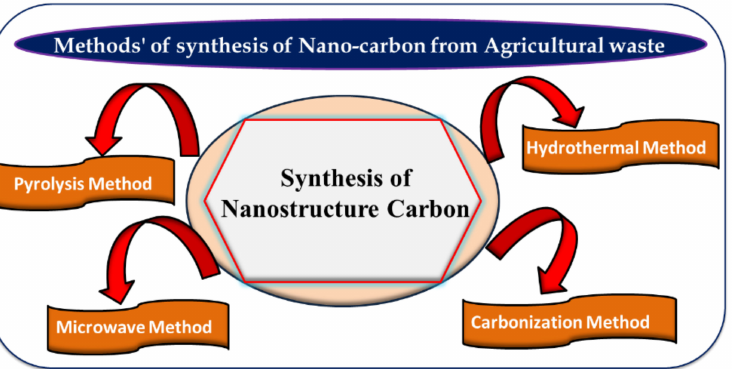
Figure 1. Various methods such as pyrolysis, microwave, hydrothermal, and carbonization for nanocarbon synthesis from agricultural waste.